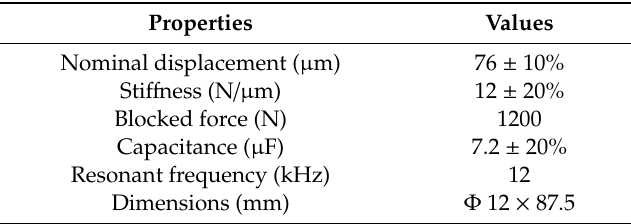
Figure 17. Experimental setup of the positioning stage: ( a ) Schematic diagram, and ( b ) photograph of the experimental setup. Table 4. Technical parameters of the PEA.